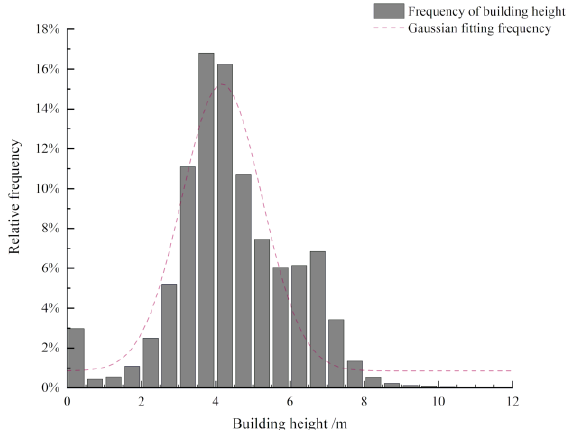
Figure 14. Frequency distribution diagram of building heights.